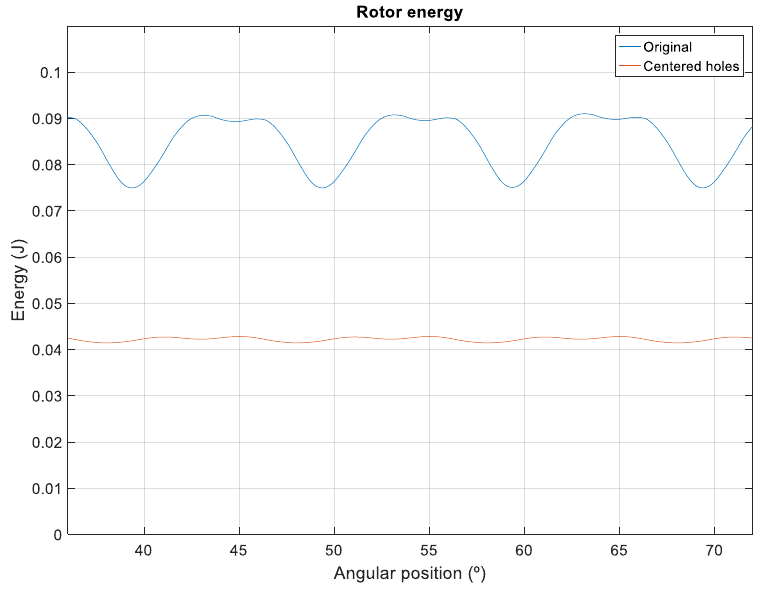
Figure 11. Magnetic energy in the rotor.